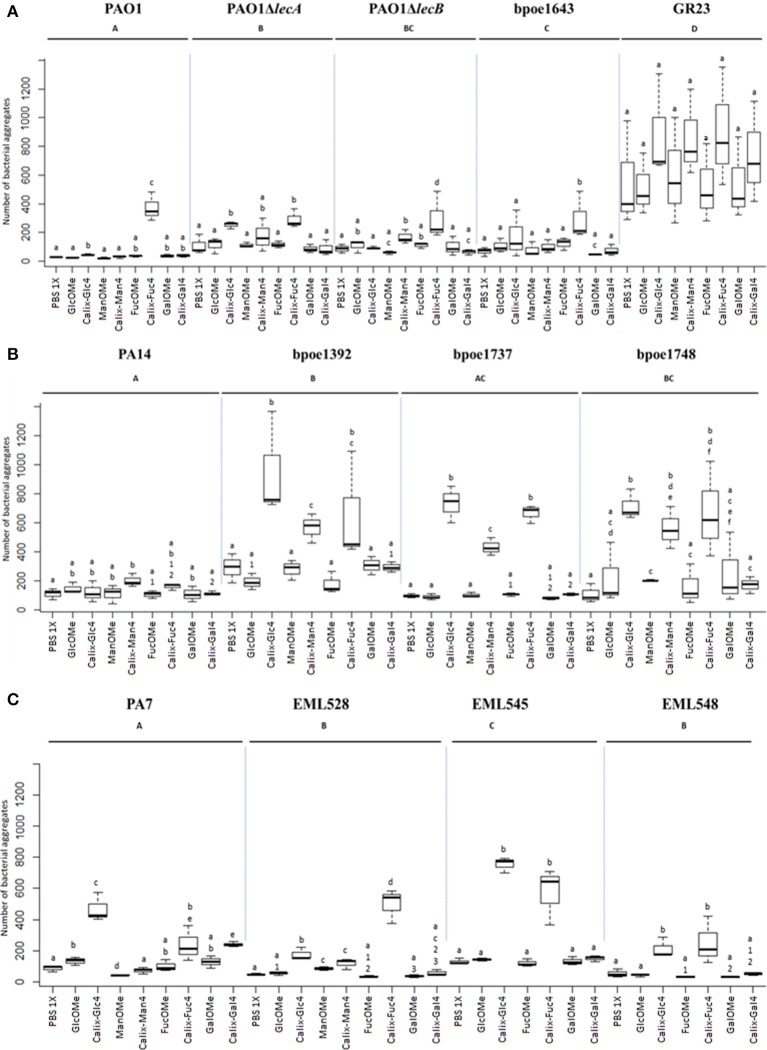
Box-plots of P. aeruginosa cells aggregation values obtained from tetravalent calixarene glycoclusters (Calix-Glc4, Calix-Man4, Calix-Fuc4, and Calix-Gal4). Number of cell aggregates (>20 μm2) were measured by FlowSight cytometry, and compared with those obtained after exposure to methyl glycosides (GlcOMe, ManOMe, FucOMe, and GalOMe). These assays were performed on P. aeruginosa strains of (A) LecB cluster I (PAO1, its isogenic mutants PAO1ΔlecA and PAO1ΔlecB, bpoe1643 and GR23), (B) cluster II (PA14, bpoe1392, bpoe1737 and bpoe1748), and (C) cluster III (PA7, EML528, EML545 and EML548) (according to Figure 1). Aggregation levels were recorded from 20,000 cellular events. All tests were at least triplicated. Letter codes indicate the statistical significance of the tests. A same letter code indicates the absence of significant difference between the data sets (p > 0.05), and a distinct letter code indicates significant differences (p < 0.05). Each black bar in a box shows the median value in terms of number of aggregates obtained for all the tests that were performed.